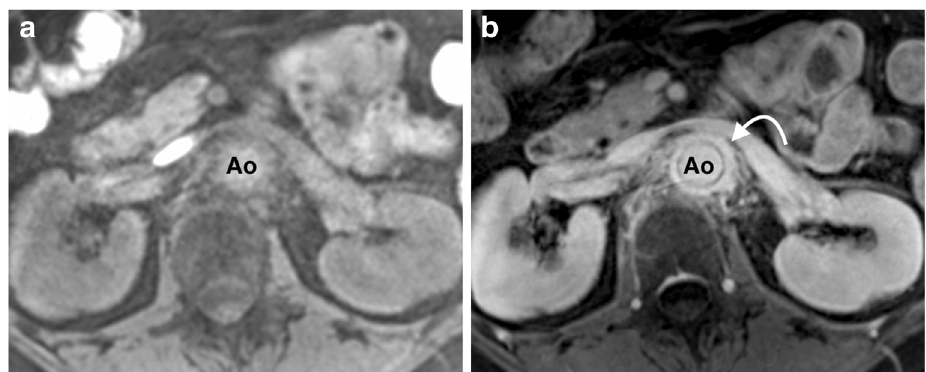
Fig. 7 Selected axial images from T1-weighted 3D spoiled gradient echo sequence with a fat selective prepulse sequence pre- ( a ) and post- ( b ) gadolinium in a 55-year- old woman with giant cell arteritis demonstrates enhancing circum- ferential mural aortic soft thick- ening ( arrow ) of the juxtarenal aorta ( Ao ) consistent with a large vessel vasculitis